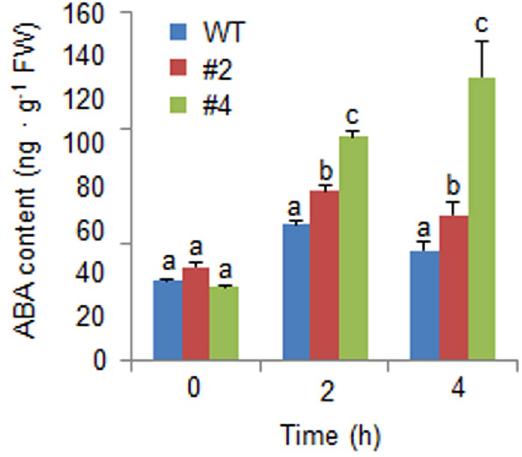
Figure 7. Increased accumulation of ABA in CaREL1- OX plants exposed to drought stress. The ABA contents in the leaf tissues were measured 0 h, 2 h, and 4 h after drought stress